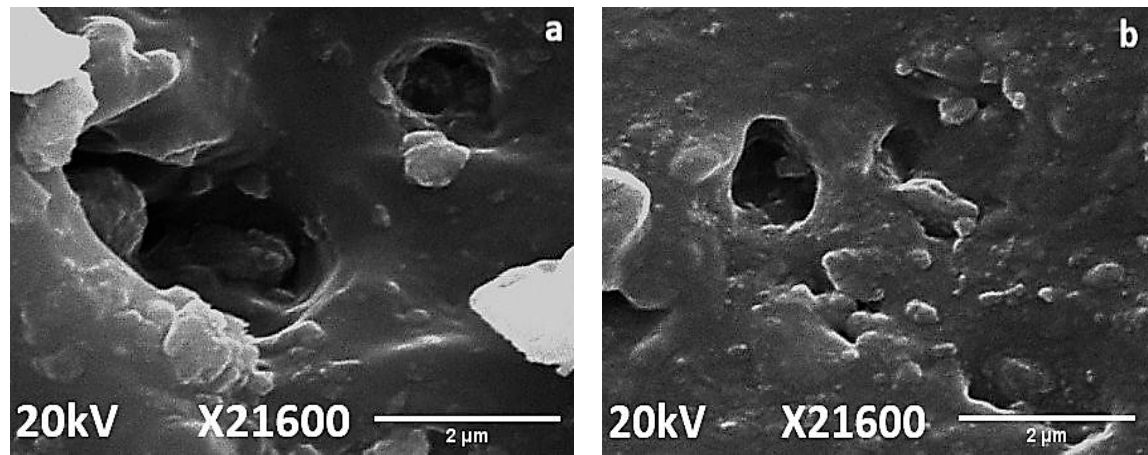
Figure 10. SEM images of virgin ( a ) nSiR ( b ) SMC 15 ( c ) SNC 2.5 and ( d ) SNC 5.